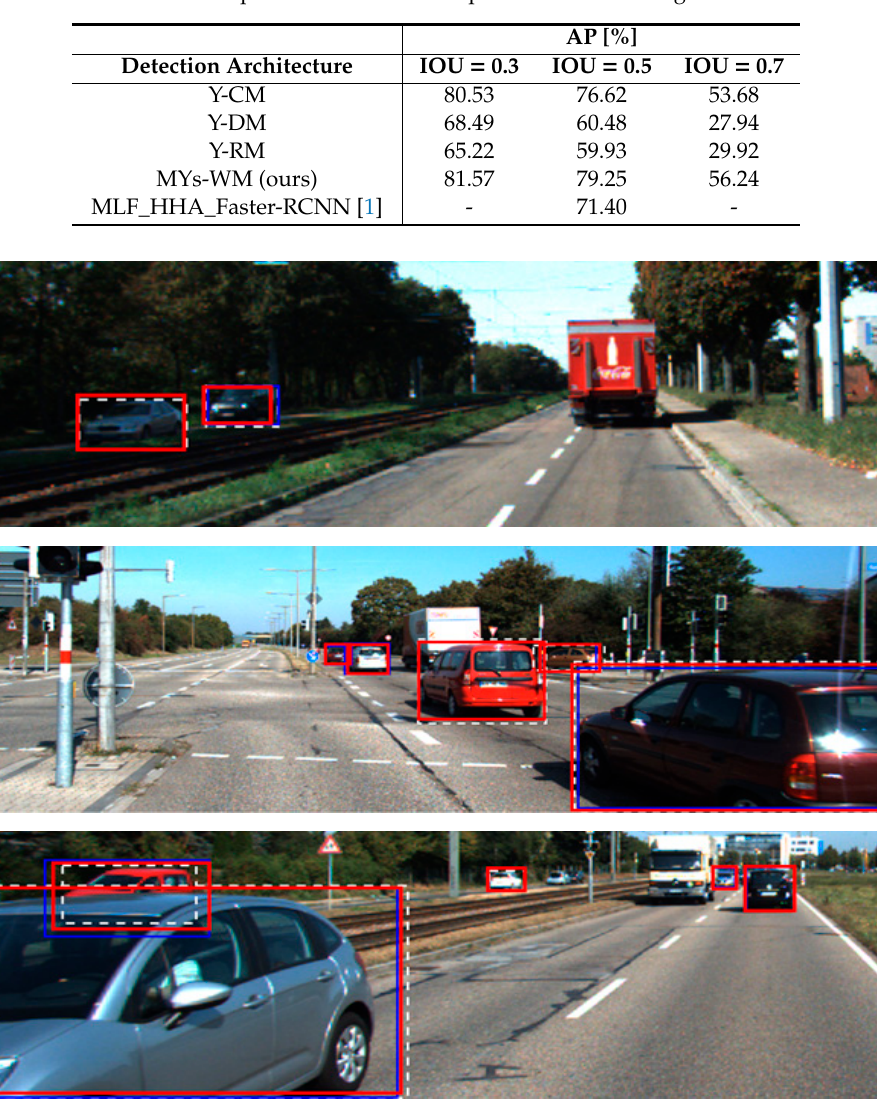
Figure 8. Comparison of car detection examples with Y-CM and MYs-WM.